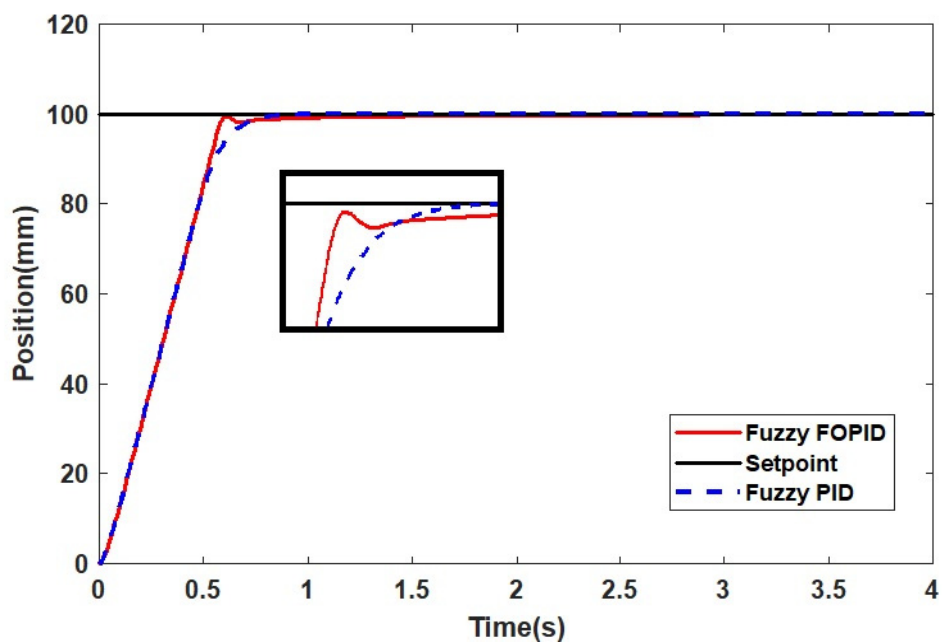
Figure 22. Dynamic response of the system with the fuzzy FOPID and fuzzy PID controllers under parametric uncertainties, case 2.